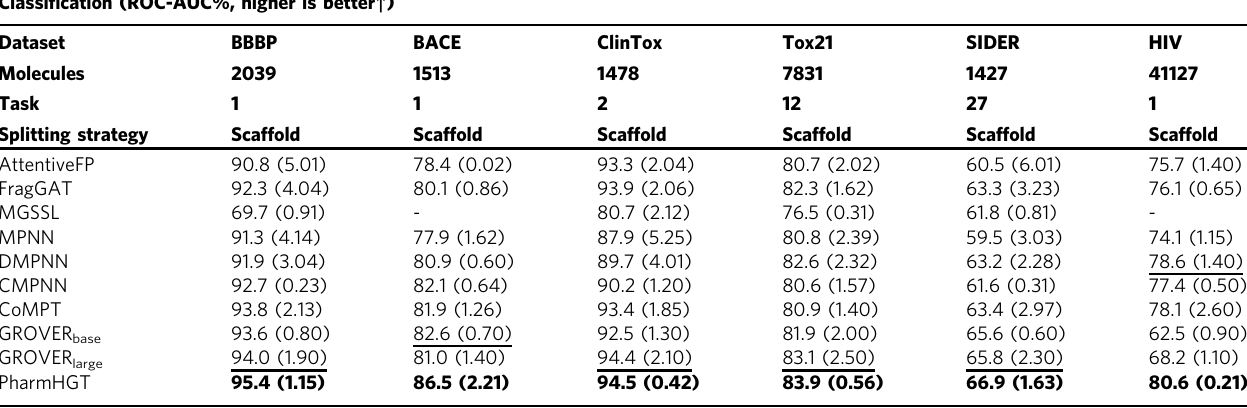
Table 1 Overall performance comparison to the state-of-the-art methods on molecular property prediction classi fi cation tasks. Classi fi cation (ROC-AUC%, higher is better ↑ )